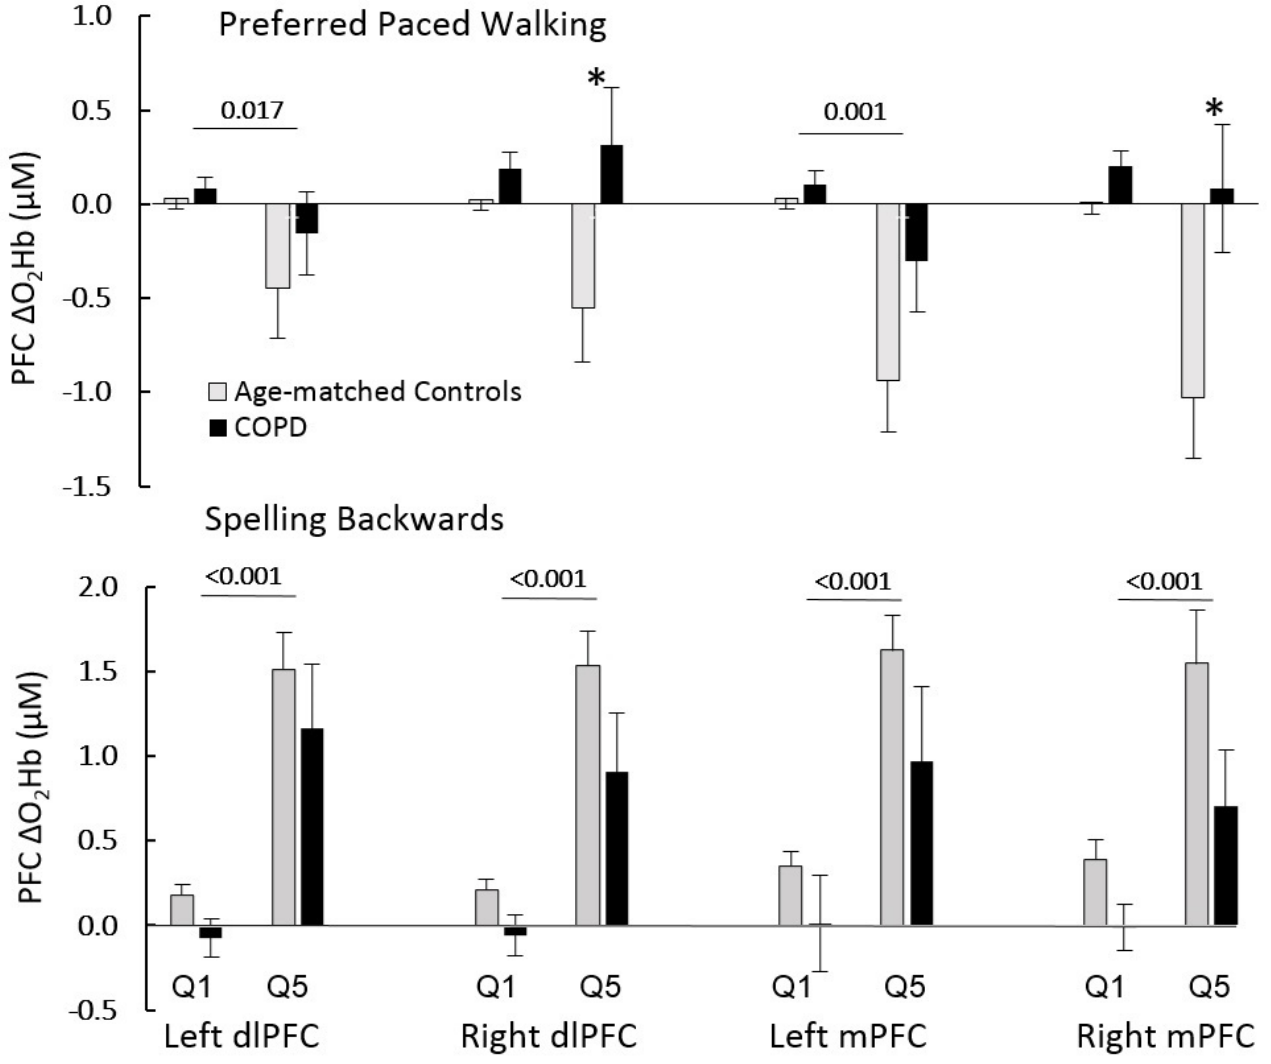
Figure 1. Changes in medial (mPFC) and dorsolateral prefrontal cortex (dlPFC) O 2 Hb from the first (Q1) to the last quintile (Q5) of the single task durations: preferred paced walking ( upper panel ) and spelling backwards for 60 s ( lower panel ). Means and SE are shown. Horizontal bars indicate the main effects between Q1 and Q5 (mixed 2-way ANOVA). * COPD different than age-matched controls at p < 0.05.